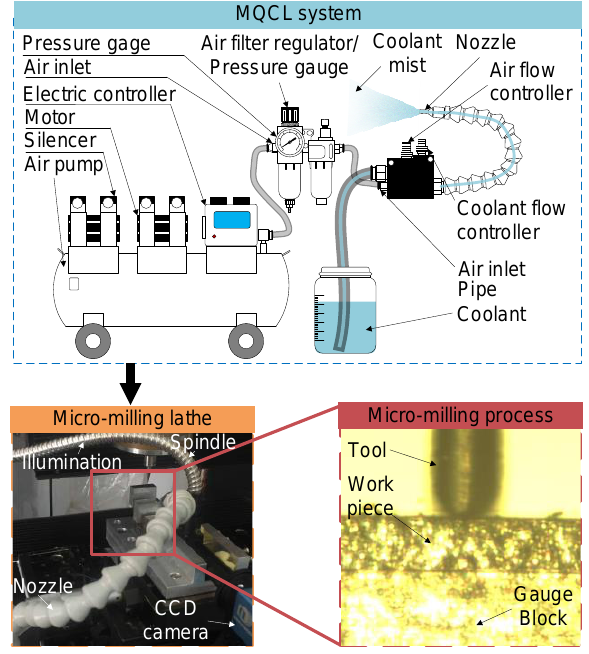
Figure 2. Micromilling machine tool. Table 1. Related information of the employed micromilling tool.